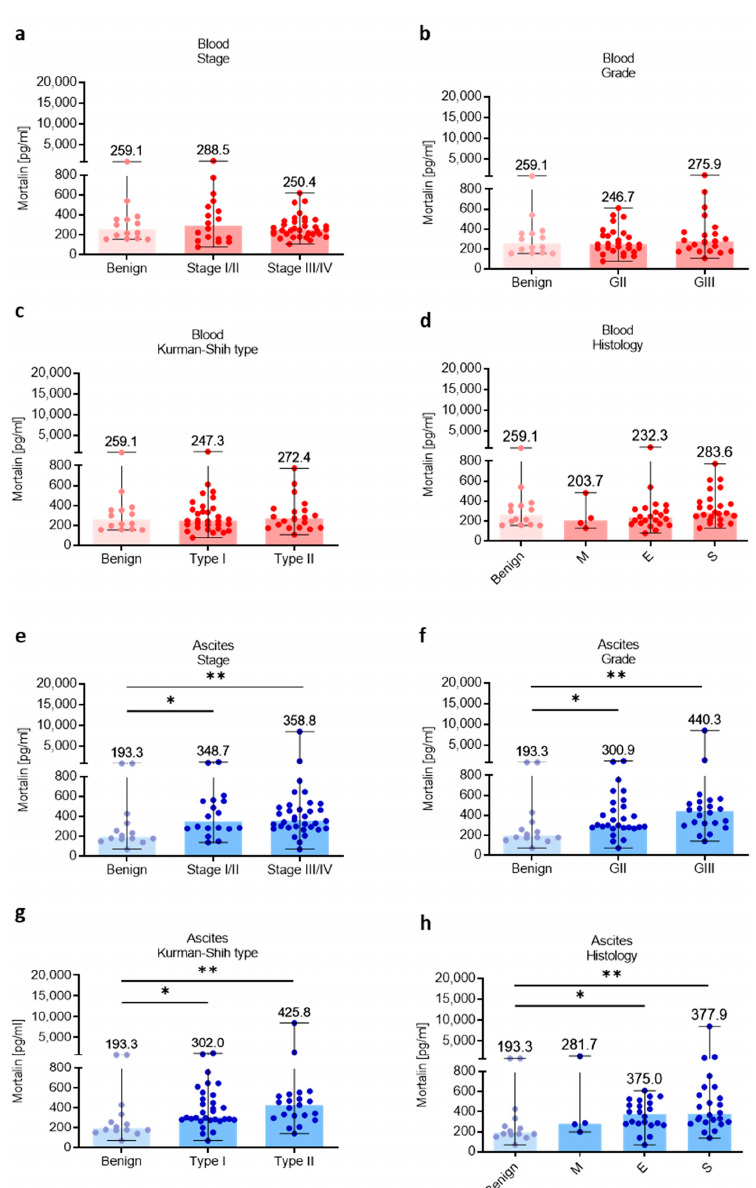
Figure 3. Mortalin profile in patients with different clinicopathologic characteristics. Mortalin levels in patients with benign ovarian tumors and ovarian cancer with different stage ( a ), grade ( b ), Kurman–Shih type ( c ), and histology type ( d ) in the blood plasma. Mortalin levels in patients with benign ovarian tumors and ovarian cancer with different stage ( e ), grade ( f ), Kurman–Shih type ( g ), and histology type ( h ) in the ascites fluid. Bars represent medians and ranges. * p < 0.05, ** p < 0.01. E—endometrioid OC; M—mucinous OC; S—serous